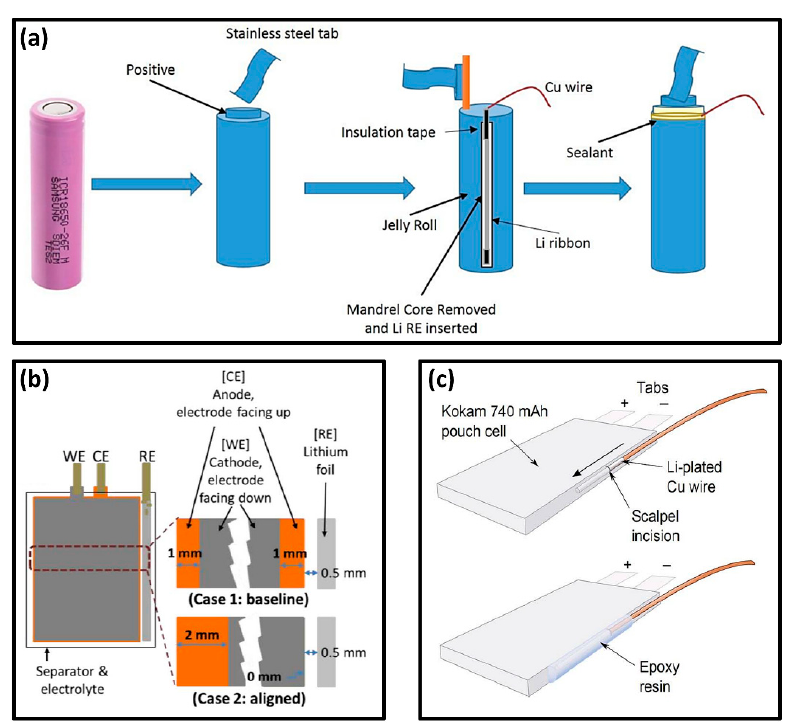
Figure 18. Schematic representation of RE implementation for cylindrical ( a ) and pouch ( b , c ) cells. Reproduced with permission from [36,38,112].